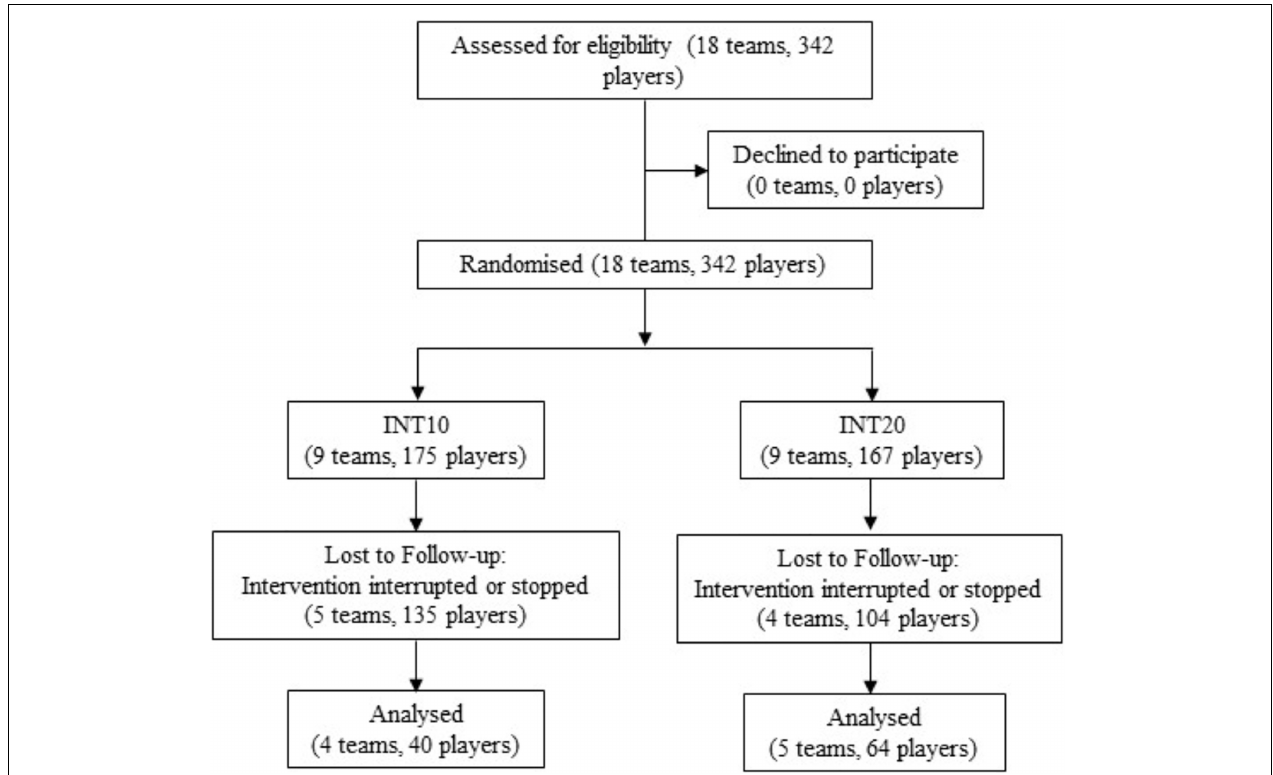
FIGURE 1 | Flow diagram of team and player participation through the study